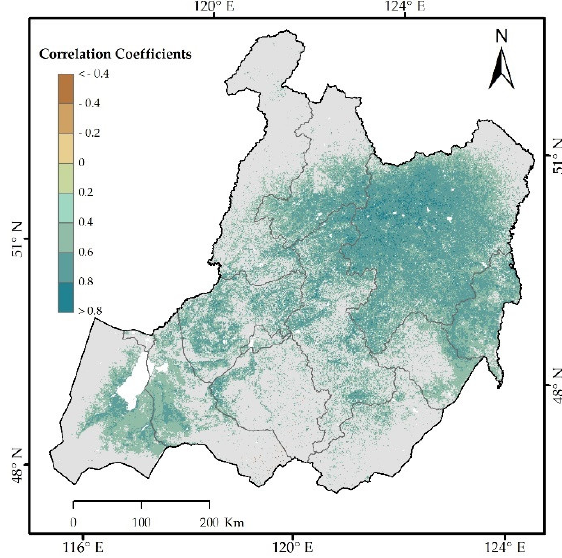
Figure 8. Correlation coefficients between snow depth and the LSWI during the period of 2001–2018.